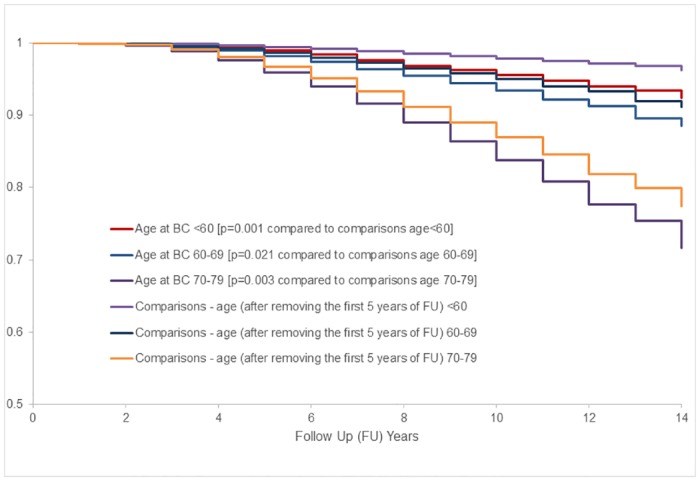
Age adjusted survival curves for total mortality among women with localized breast cancer vs. no breast cancer comparisons.BC indicates breast cancer. For more details regarding each age group, see S1–S3 Figs.